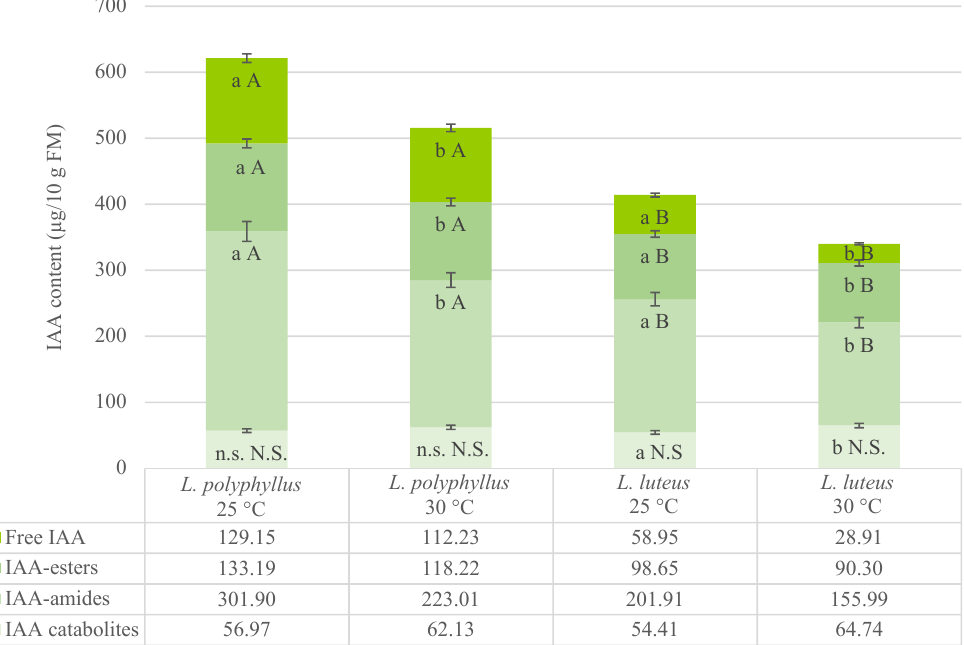
Figure 2. IAA content in cotyledons of seedlings grown at 25 °C and 30 °C. Vertical bars represent the total IAA content. Sub-bars depict the content of IAA compounds. Values are mean ± SD of three experiments with five replicates in each. Different uppercase letters indicate significant difference ( p < 0.05) between mean values of two lupine species grown under the same temperature; N.S.—non-significant difference. Significant difference between mean values at 25 °C and 30 °C for each lupine species is marked with different lowercase letters; n.s.—non-significant difference.